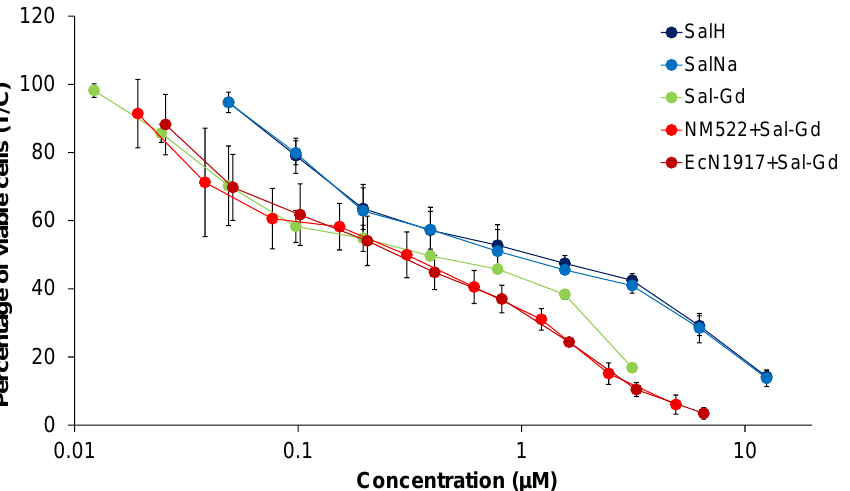
Figure 8. Concentration-effect curves of SalH, SalNa, Sal-Gd(III), NM522 + Sal-Gd(III) and EcN1917 + Sal-Gd(III) in A549 ( top ), CH1/PA-1 ( middle ) and SW480 ( bottom ) cells, determined by the MTT assay after 96 h treatment. Values are normalized relative to untreated controls and represent means and standard deviations of at least three independent experiments.